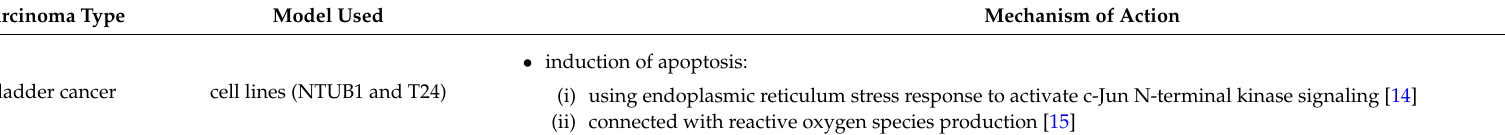
Table 1. Ursolic acid in cancer